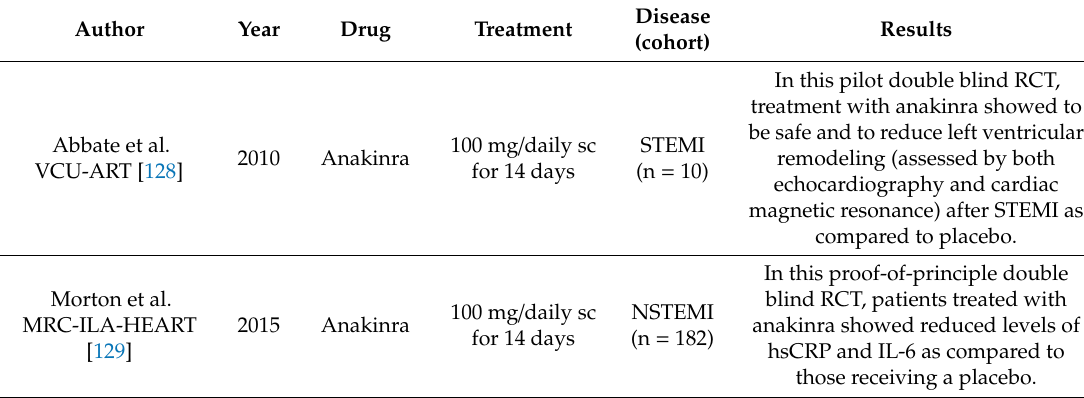
Table 2. Clinical studies investigating the e ff ect of IL-1 inhibition in preventing cardiac remodeling after myocardial